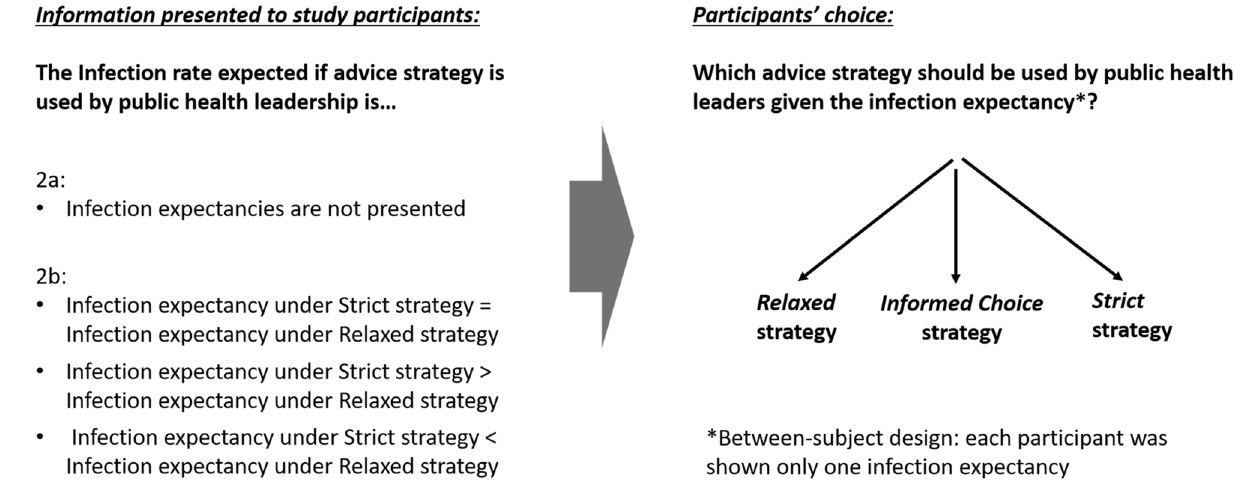
Figure 4. Experiment design, Study